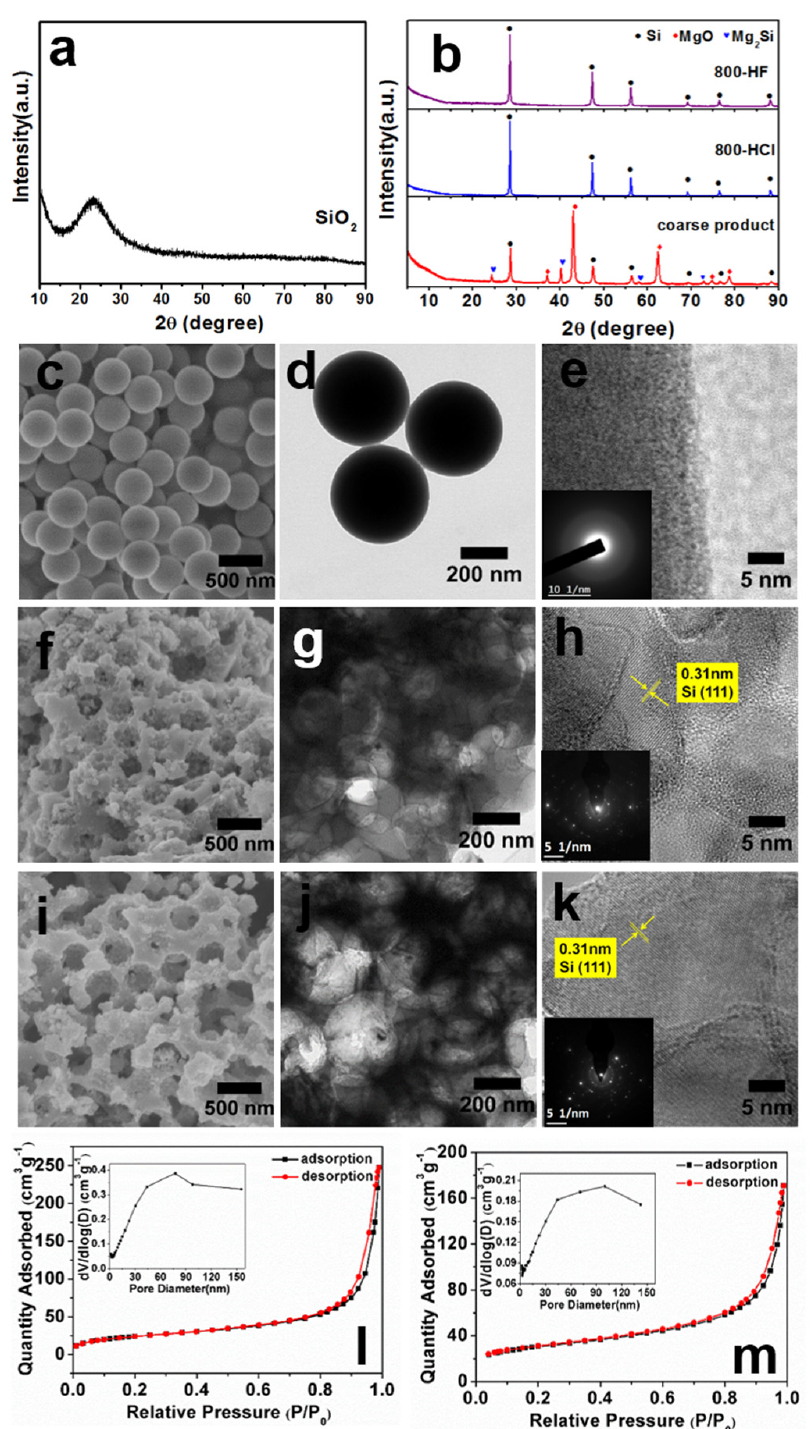
Figure 1. XRD patterns of the pristine SiO 2 , coarse product of the reduction, 800-HCl, and 800-HF ( a , b ). SEM ( c , f , i ), TEM ( d , g , j ), HRTEM ( e , h , k ) images and SAED patterns (insets of images ( e , h , k )) of the pristine SiO 2 ( c – e ), 800-HCl ( f – h ), and 800-HF ( i – k ). N 2 adsorption and desorption isotherms and the corresponding BJH pore size distribution curves of 800-HCl ( l ) and 800-HF ( m ). The subsequent treatment with diluted HCl selectively dissolved the MgO and Mg 2 Si byproduct, so only diffraction peaks of Si were obvious in the XRD patterns of 800-HCl. HF treatment did not change the crystallinity of